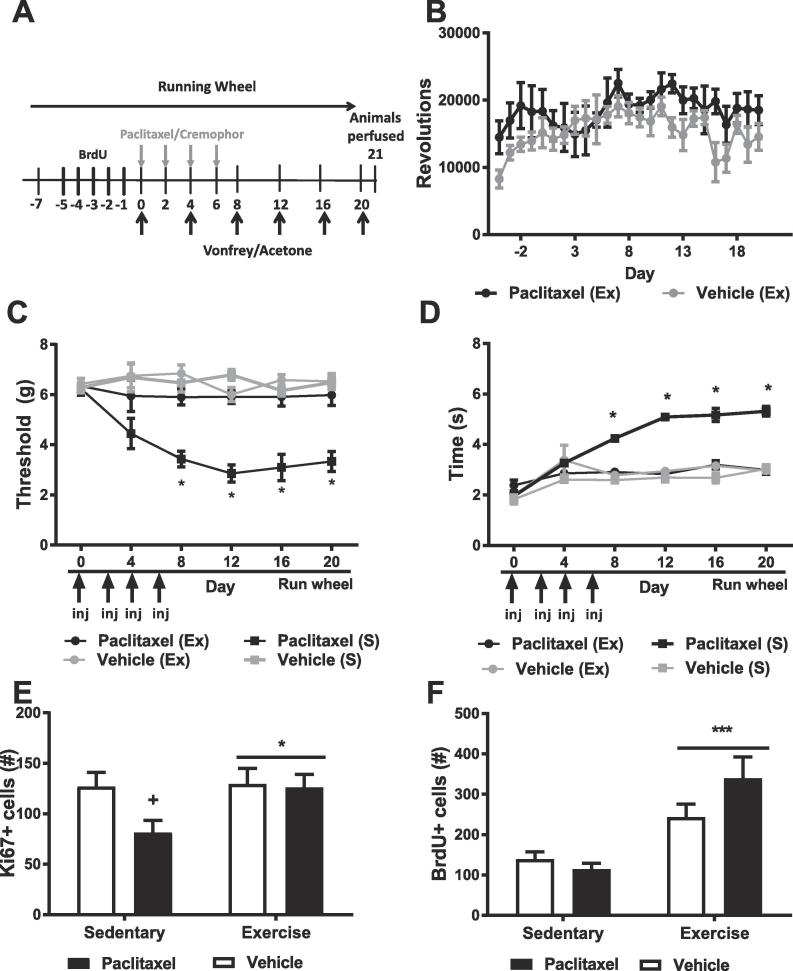
Voluntary running prevents the development of paclitaxel-induced allodynia and increases markers of cellular proliferation and survival in the dentate gyrus of the hippocampus. (A) Schematic shows timing of experimental procedures in Study 1. Voluntary running began 7 days prior to paclitaxel (4 mg/kg i.p. on day 0, 2, 4 and 6) or vehicle injections. Animals were tested for mechanical and cold hypersensitivity for a period of 20 days followed by perfusion on day 21 post paclitaxel or vehicle injection. BrdU (100 mg/kg i.p.) was administered once daily across 5 consecutive days prior to initiation of dosing with paclitaxel or its vehicle. (B) Running wheel rates did not differ in mice treated with paclitaxel or vehicle. Mice allowed to engage in voluntary exercise did not display hypersensitivities to mechanical (C) or cold (D) stimulation in contrast to sedentary mice without access to running wheels. Voluntary running did not alter responsivity to mechanical or cold stimulation in vehicle-treated animals. Paclitaxel treatment decreased the number of Ki67 (E) but not BrdU (F) labeled cells compared to vehicle treatment in sedentary mice. Voluntary running increased both Ki67 and BrdU expression levels irrespective of chemotherapy treatment condition. *p < 0.05 vs. all other groups, two-way ANOVA followed by Bonferroni post-hoc. Exercise, Ex, indicates subjects exposed to running wheels. Sedentary, S, indicates subjects housed without running wheels. (C,D) Arrows denoting injections (inj) denote timing of paclitaxel or vehicle injection. Horizontal arrow denotes timing of voluntary running. (E,F) *p < 0.05 main effect Exercise vs. Sedentary, +p < 0.05 vs. vehicle, Two-Way ANOVA followed by Bonferroni post-hoc. Data are expressed as mean ± SEM. N = 5–6 per group.